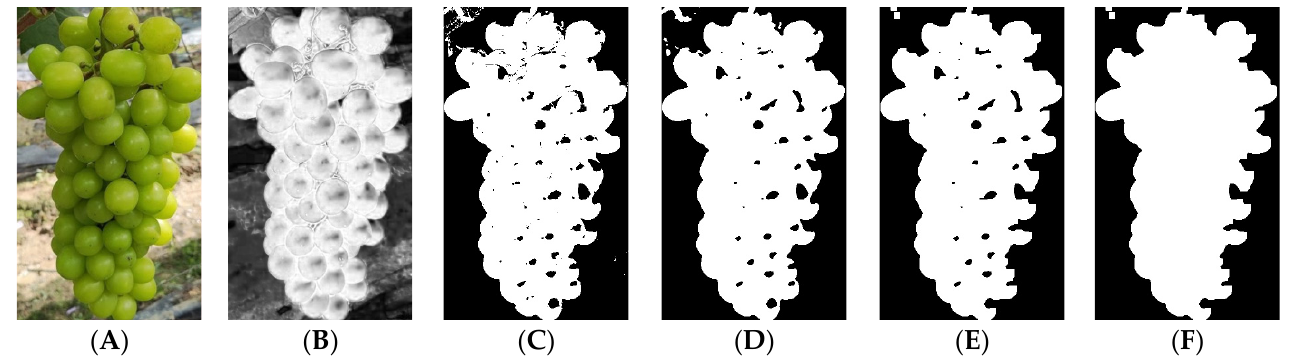
Figure 10. Image segmentation. Original image ( A ), S channel image ( B ), binary image ( C ), median filter ( D ), open operation ( E ), and hole filling ( F ).